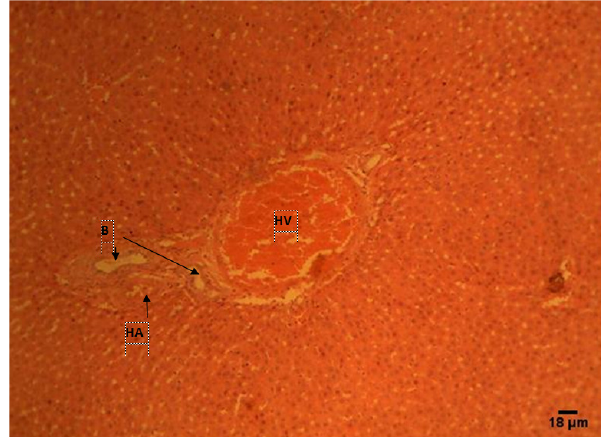
Fig. 5. Histological appearance of liver of rat given 0.5 mg/kg body weight of quail egg orally for 63 days, showing no obvious lesions. Note the hepatic artery (HA), hepatic vein (HV)